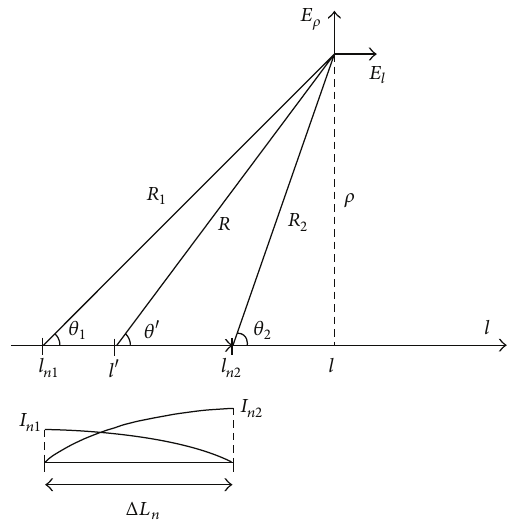
Figure 3: Local coordinate system of one generic sinusoidal current segment of (6) used for calculation of components of radiated electric fields in (12).